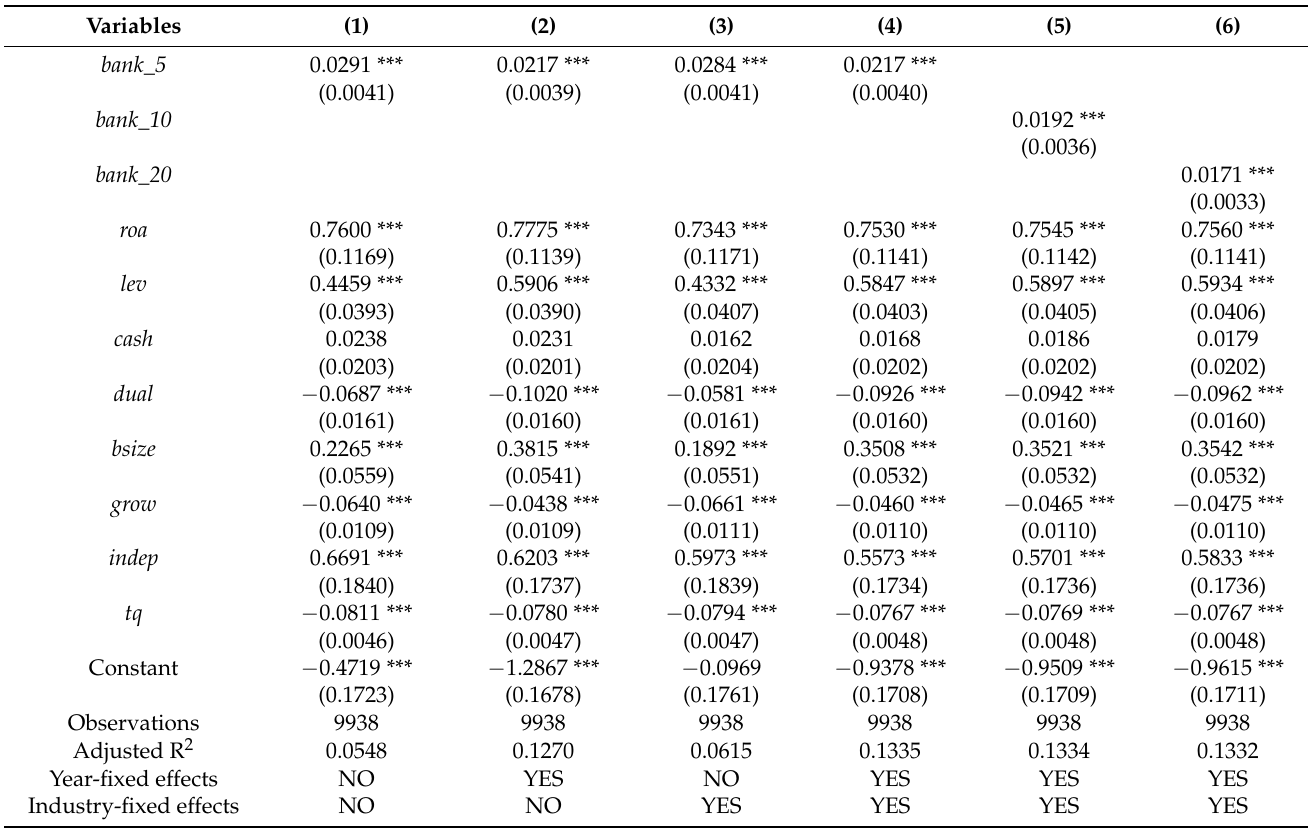
Table 5. Estimates using resource enterprises’